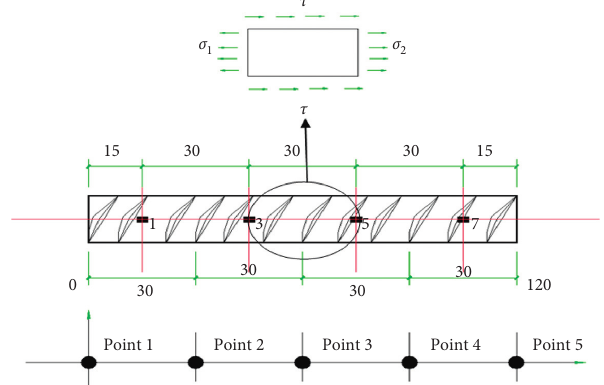
Figure 6: Calculation points for the local